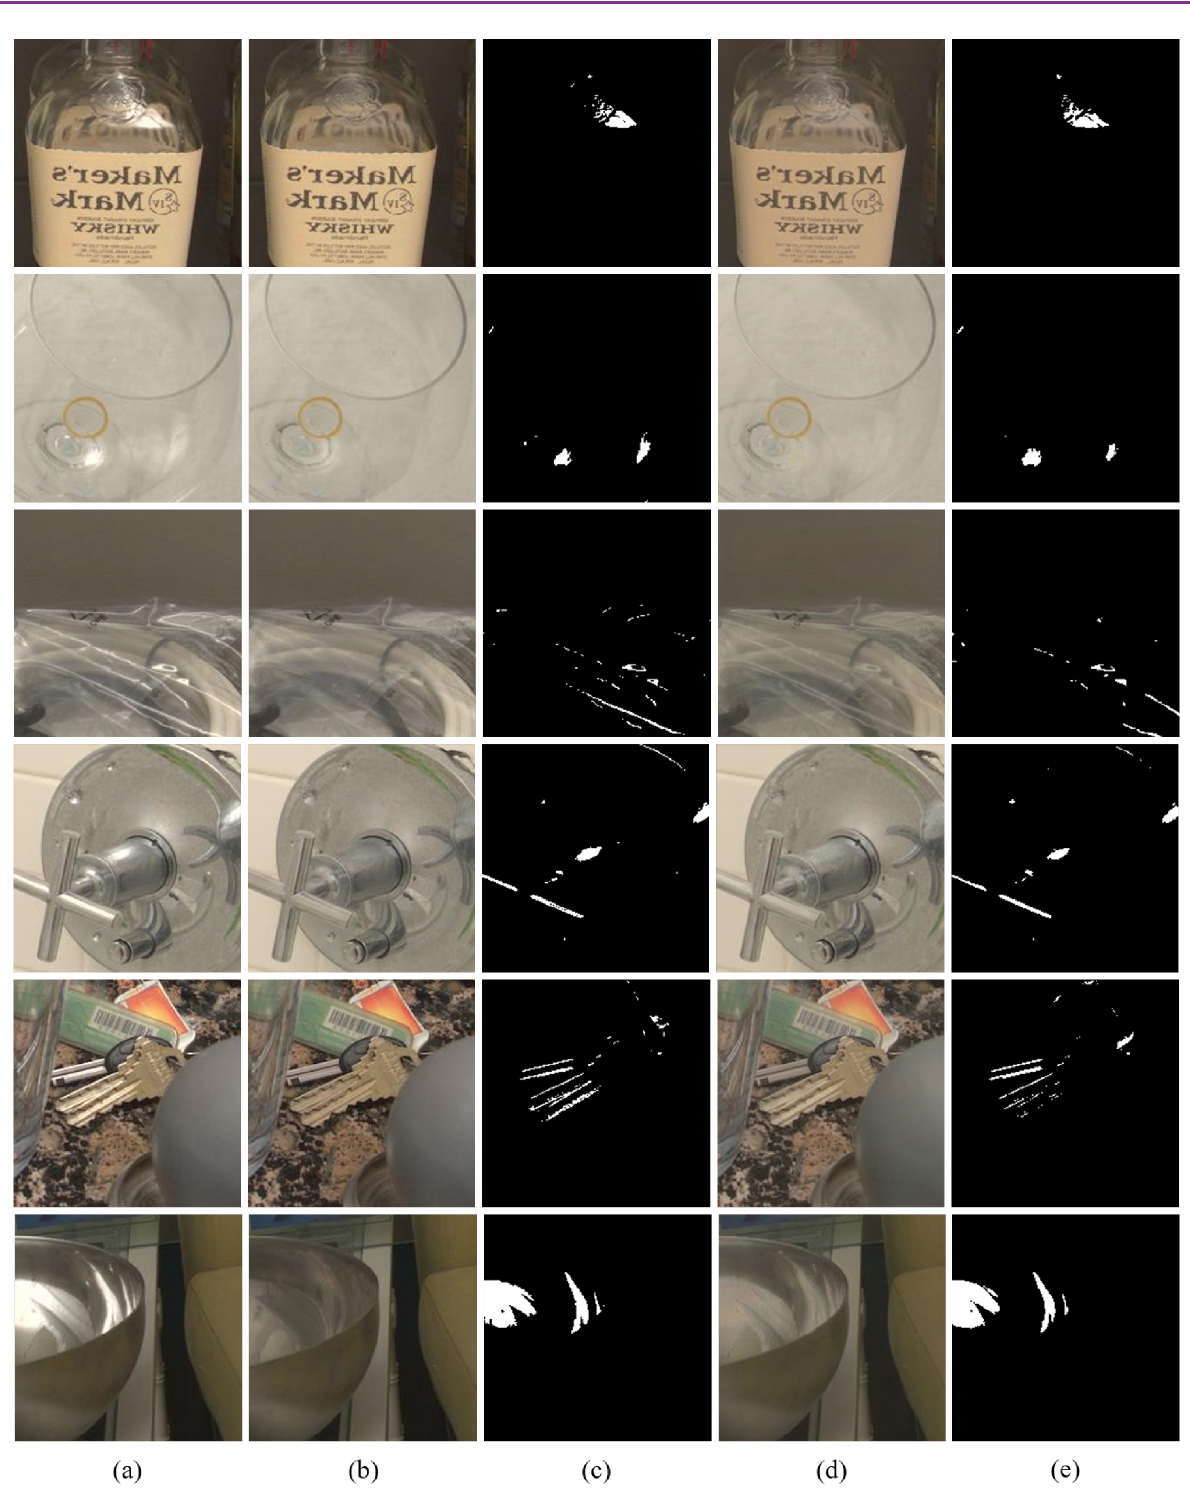
Fig. 4 Specular highlight detection and removal results using our neural network: (a) input images with specular reflections, (b) ground-truth diffuse images, (c) ground-truth masks of the specular highlights, (d) our removal results, and (e) our detection results.